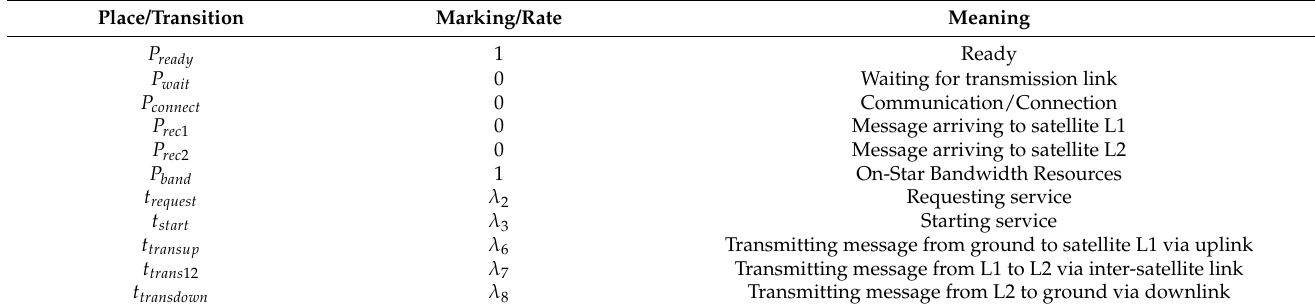
Table 2. List of SPN objects in Figure 5.